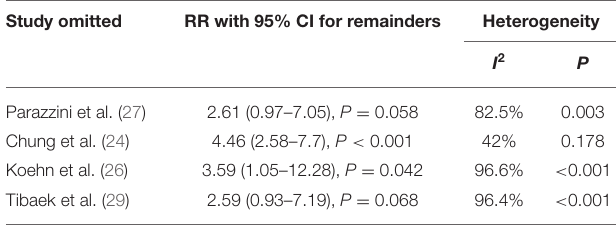
TABLE 3 | Sensitivity analysis after each study was excluded by